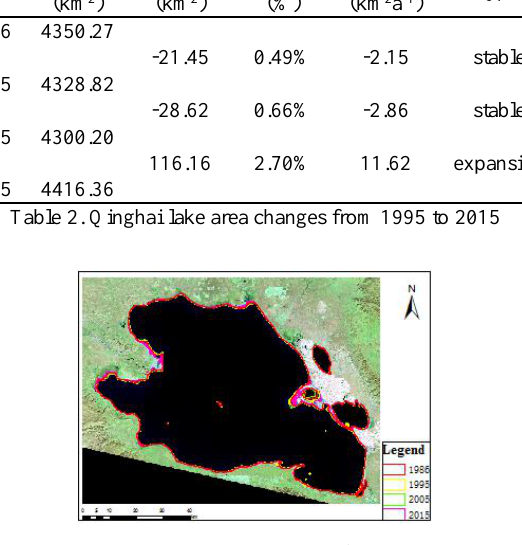
Figure 13. Qinghai lake area changes from 1995 to 2015